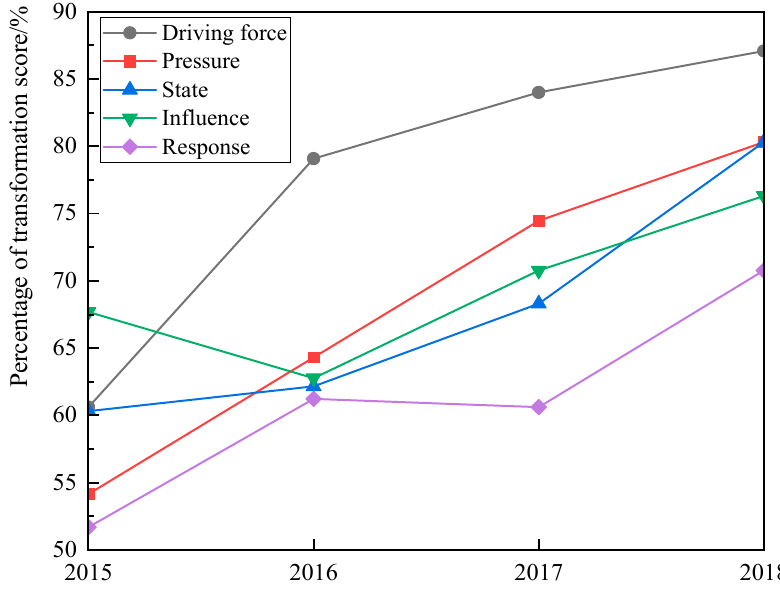
Figure 7. Percentage of subsystem scores in economic structure transformation of coal energy-based cities.